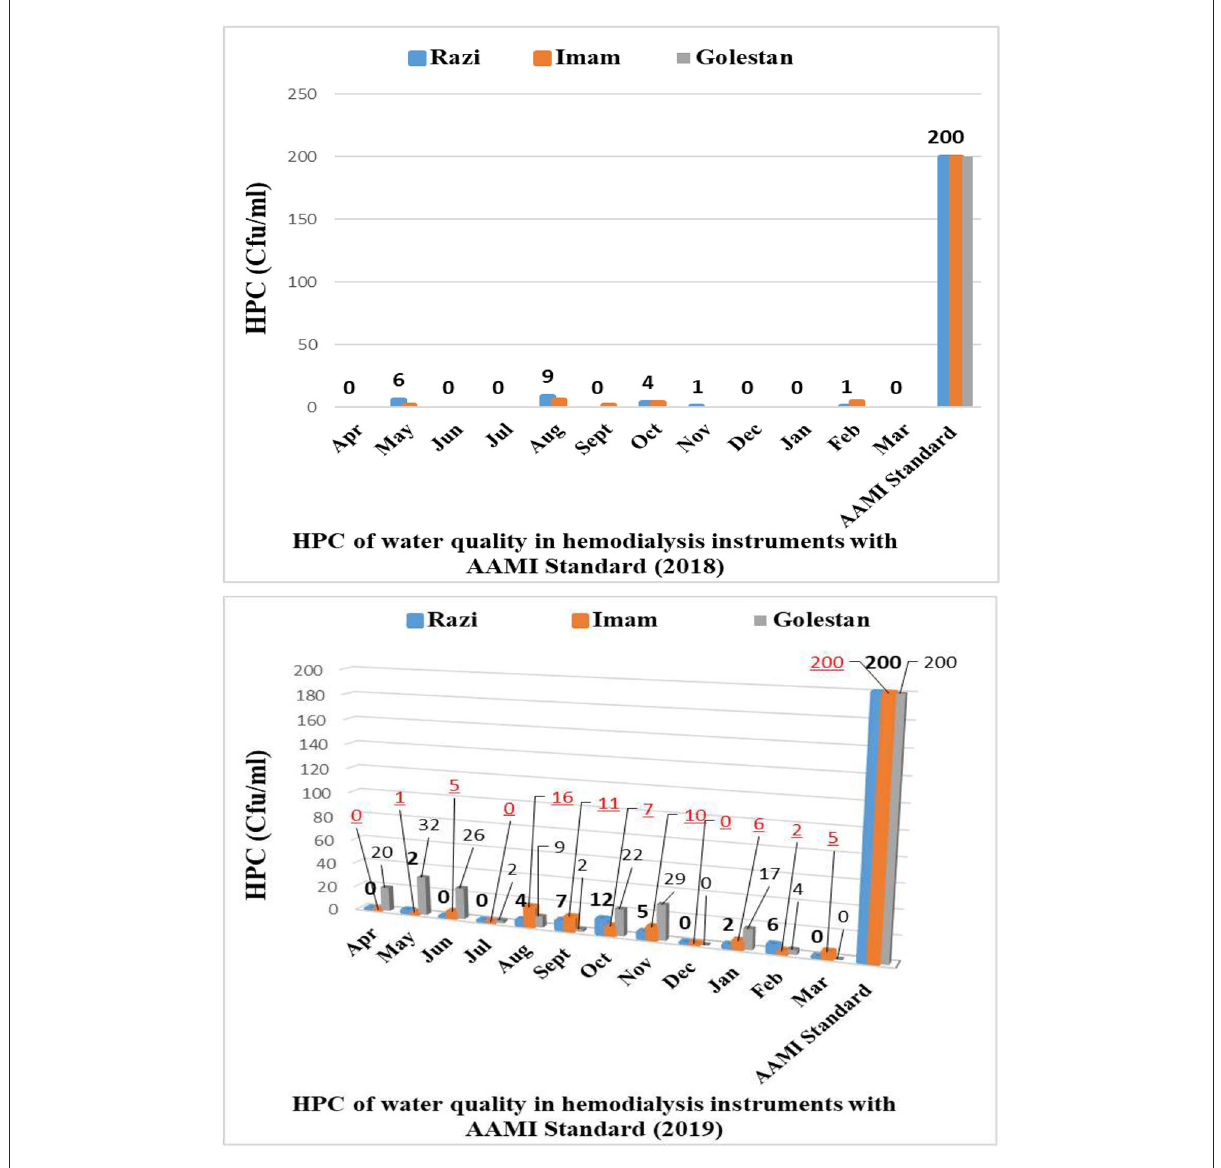
FIGURE2 The annual average concentration of heterotrophic plate count during